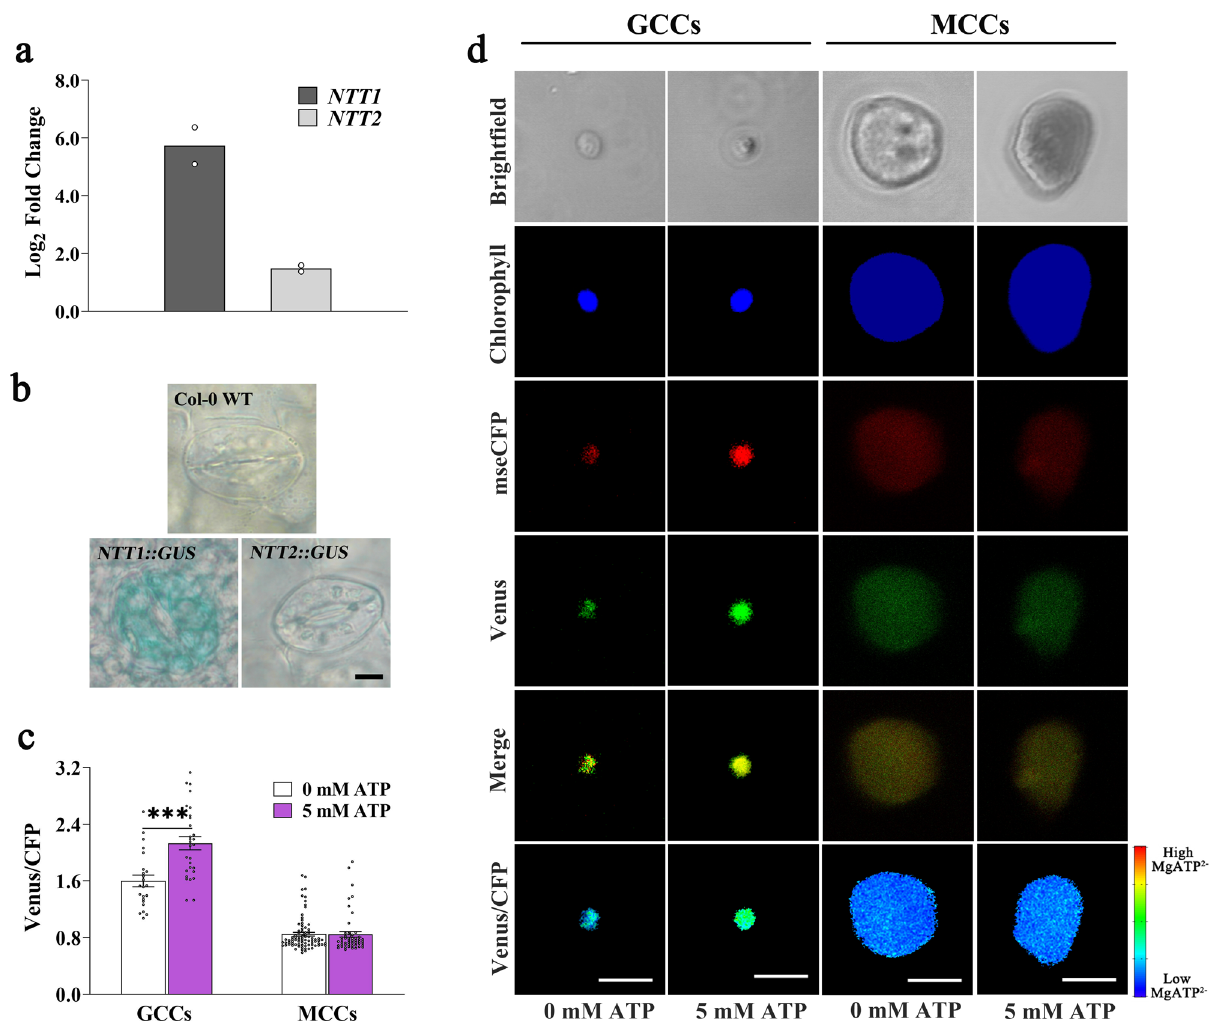
Fig. 4 Guard cell chloroplasts import ATP via the plastidial ATP/ADP translocator NTT1. a Relative transcript levels of the ATP/ADP antiporter NUCLEOTIDE TRANSPORTER 1 ( NTT1 ) and 2 ( NTT2 ) genes in GC-enriched epidermal peels compared to leaves of wild-type plants. ACTIN 2 was used as a housekeeping gene for normalization. Values are means of two independent experiments ± SEM. Primer sequences and ef fi ciencies are given in Supplementary Table 1. b Histochemical β -glucuronidase (GUS) staining of GCs of 21-day-old leaves of plants transformed with NTT1::promoter-GUS or NTT2::promoter-GUS . This experiment was repeated three times independently. Scale bars,10 µ m. c, d Venus/CFP ratios in isolated guard cell chloroplasts (GCCs) and mesophyll cell chloroplasts (MCCs) expressing TKTP-AT1.03 after incubation for 5 min in a buffer with or without 5 mM ATP (unpaired t - tests, two-tailed at *** P < 0.001; n = 23, 29, 83, and 51, respectively; mean ± SEM; p -value: GCCs 0 mM ATP vs. 5 mM ATP = 0.1 × 10 − 3 ). Scale bars, 5 µ m. Asterisks indicate signi fi cant statistical differences (*** P < 0.001) in Venus/CFP ratios with or without exogenous ATP. Source data are provided as a source data fi